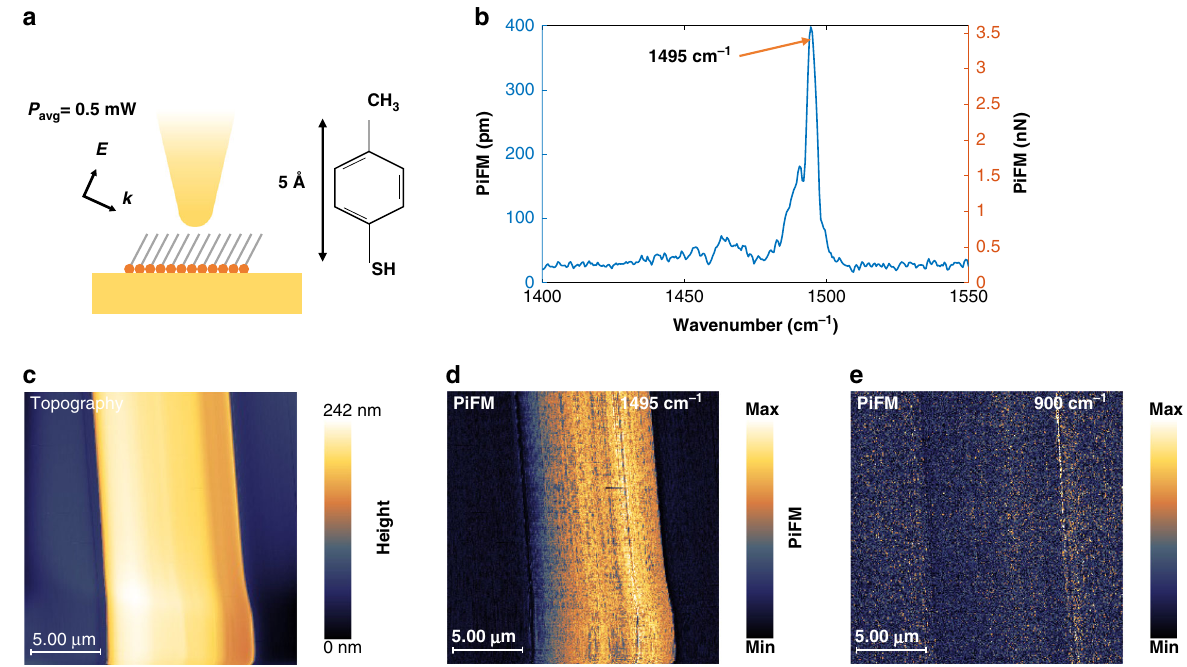
Fig. 4 Monolayer response. a is 4-MBT adsorbed on template-stripped gold. Excitation average power is 0.5 mW focused to 20- μ m-diameter spot. b is point spectrum of 4-MBT showing resonance at 1495 cm − 1 . c – e are topography of gold island, PiFM image at 1495 cm − 1 , and PiFM image off resonance,